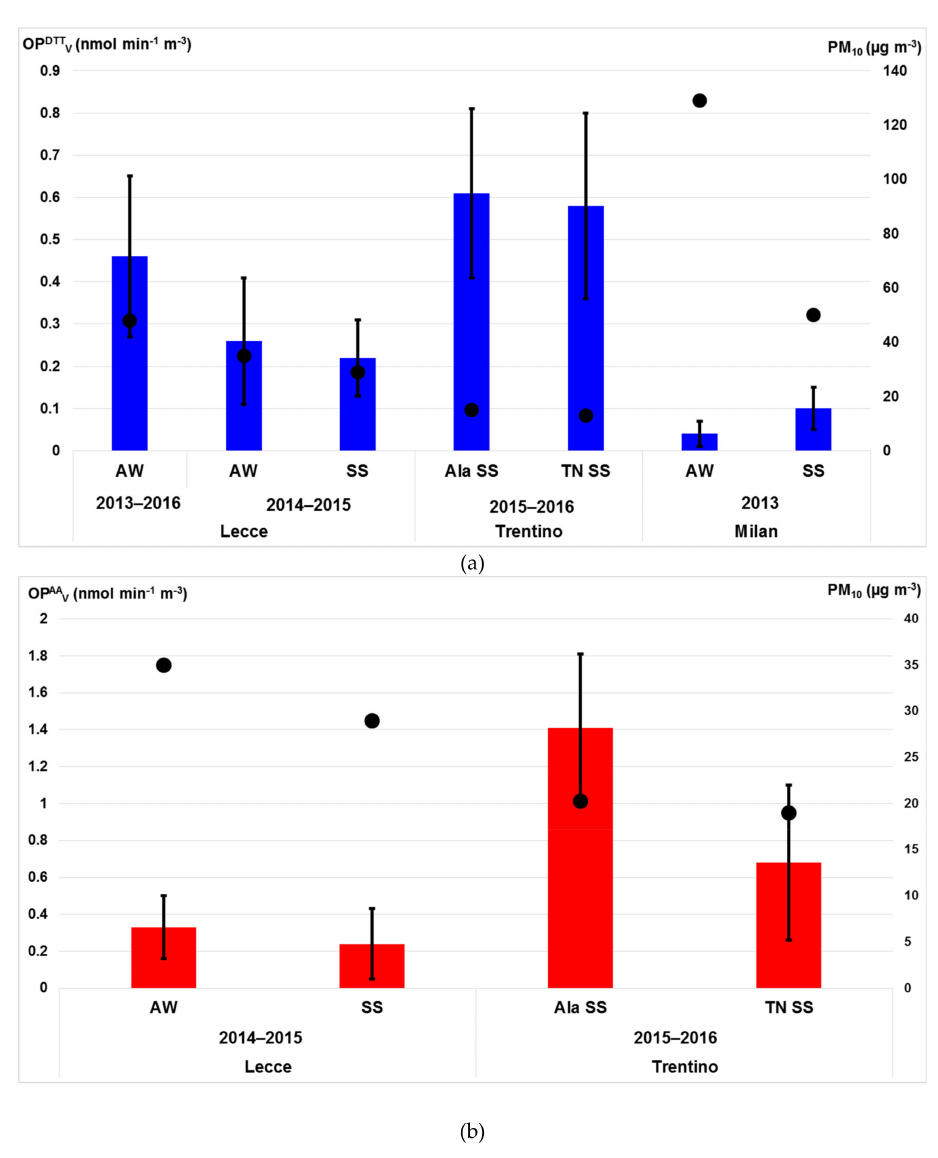
Figure 2. OP V responses of PM 10 samples measured using the same dithiothreitol (DTT) and ascorbic acid (AA) assay protocols: Mean values of each sampling campaign, standard errors are indicated by the bars. Points: Mean PM 10 mass concentration values of each sampling campaign (right y-axis): ( a ) OP DTT V values of PM 10 samples collected at Lecce (two independent studies), Trentino, and Milan (total suspended particles); ( b ) OP AA V values of PM 10 samples collected at Lecce and